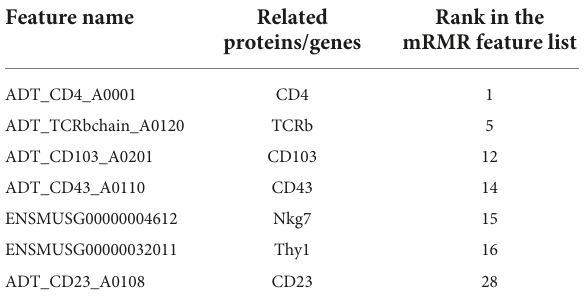
TABLE 3 Essential features for identifying spleen and lymph node cell